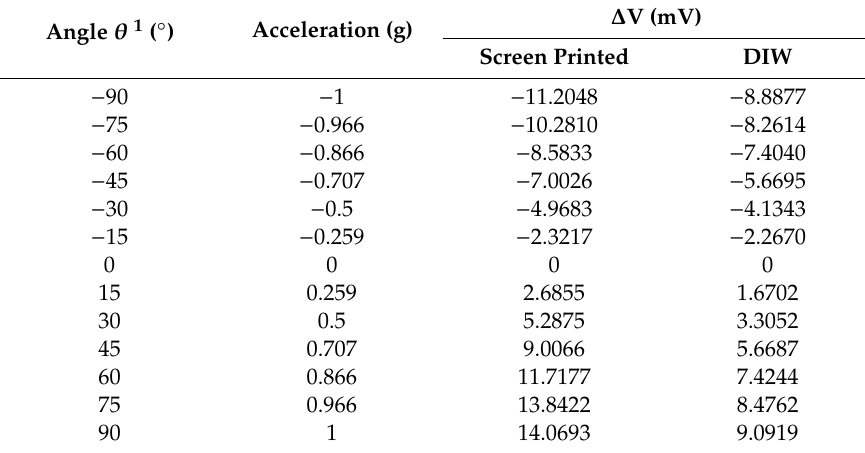
Table 4. Data from the tumbling experiments.